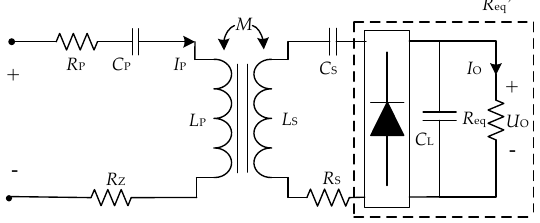
Figure 6. Equivalent circuit diagram of both sides.